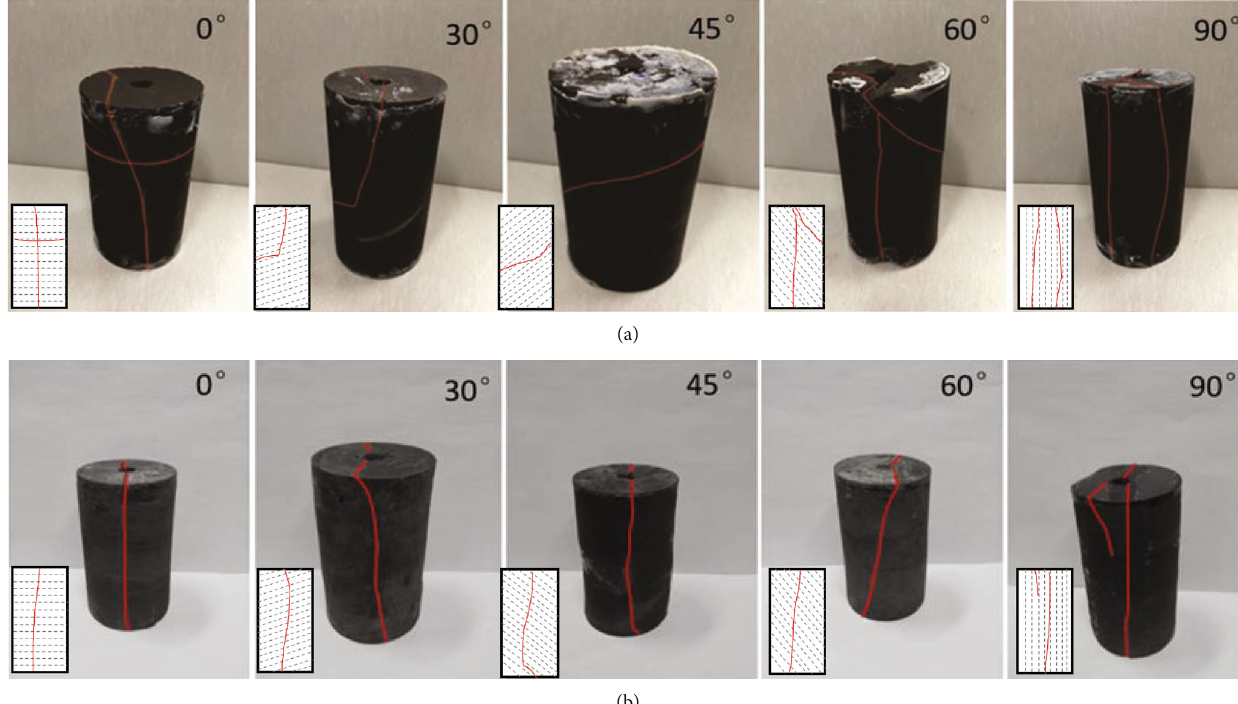
Figure 7: Macroobservation of the shale fracture morphology after fracturing. (a) Shale specimens with di ff erent bedding plane angles fractured using water. (b) Shale specimens with di ff erent bedding plane angles fractured using SC-CO the relative orientation of hydraulic fracture with respect to the bedding plane. The red lines represent the macrofractures while the dashed lines represent the bedding